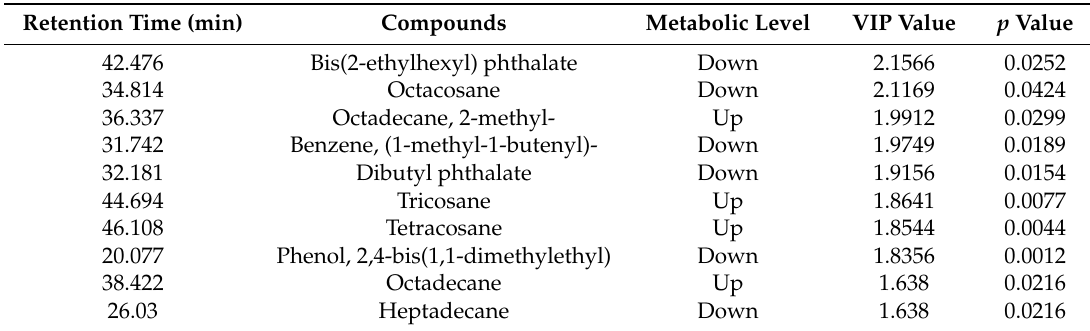
Table 4. The differently abundant metabolites from HN66 root exudates under different continuous- cropped year soil in